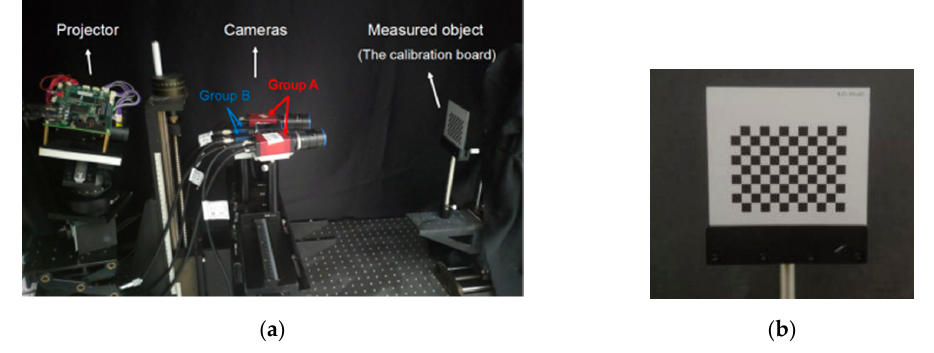
Figure 7. ( a ) Experimental setup. ( b ) Calibration board.